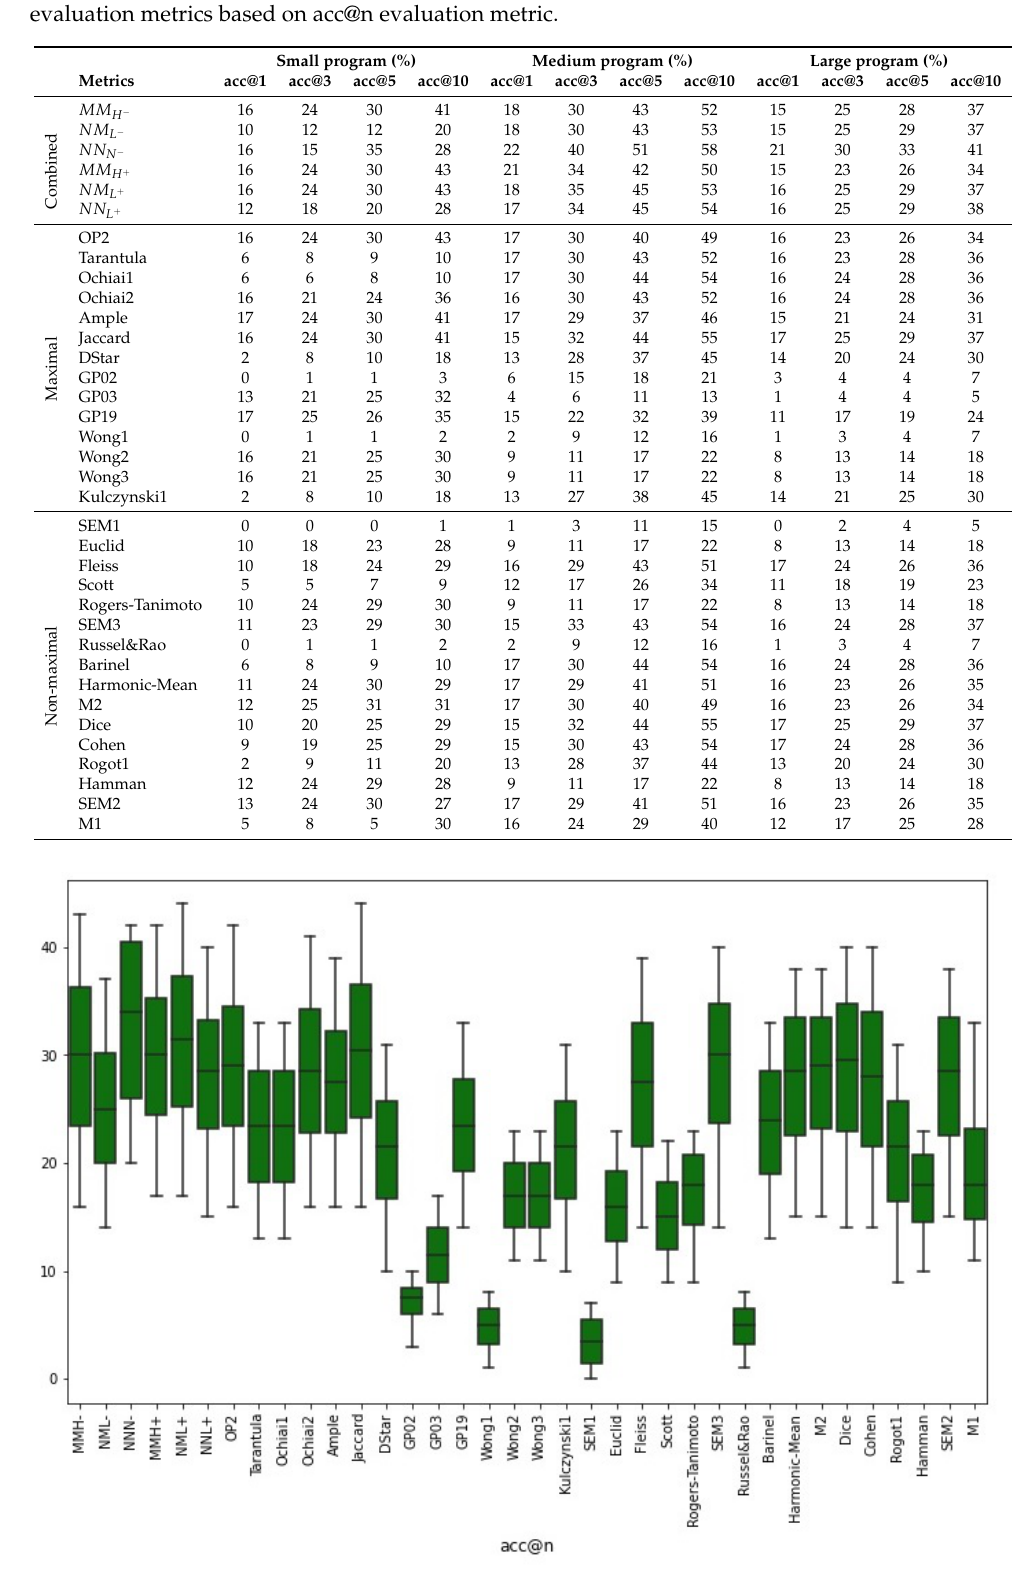
Figure 2. Fault Localization accuracy of the combined and existing risk evaluation